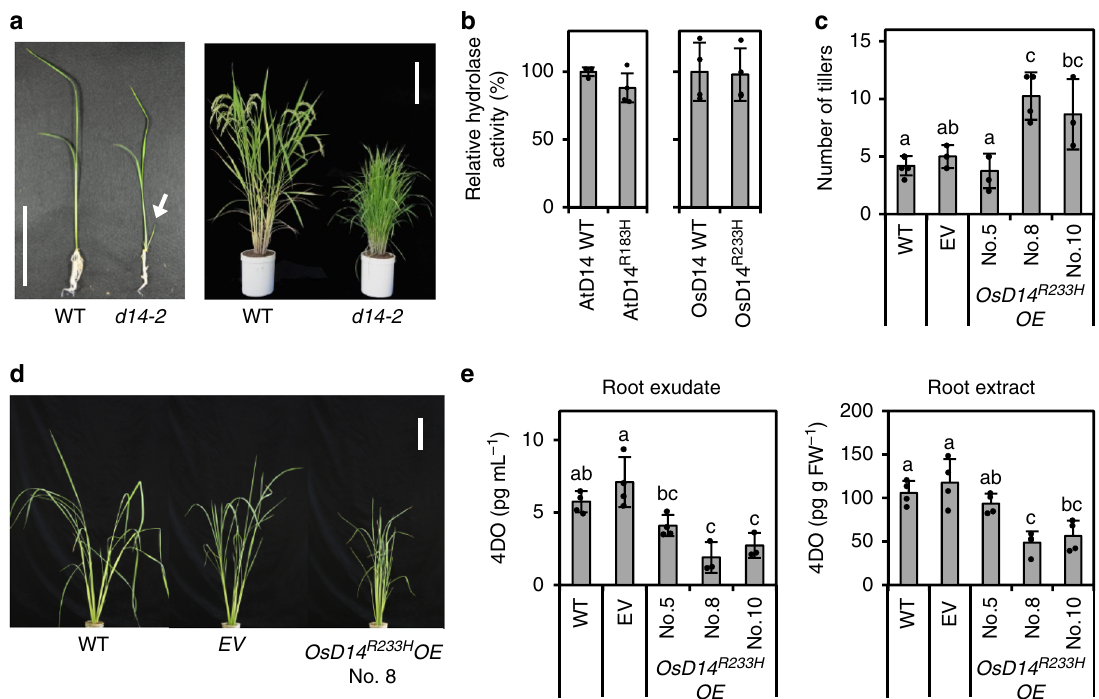
Fig. 4 In vitro and in vivo functional analysis of OsD14 R233H /AtD14 R133H . a Phenotypes of 2 weeks old seedlings (left) and mature plants (right) of the rice d14-2 mutant. The white arrow in the left picture indicates the outgrowing tiller. Scale bars = 5 cm (left panel), 20 cm (right panel). b Hydrolase activities of OsD14 R233H and AtD14 R133H mutants using 1 μ M 5DS as a substrate. Data are the means± SD ( n = 3 – 4). c No. of tillers of rice transgenic plants overexpressing OsD14 R233H in the WT (Nipponbare) background. Empty vector expressing plants are indicated as EV. Data are the means ± SD ( n = 3 – 5). d Phenotypes of 42 days old transgenic plants overexpressing OsD14 R233H ( OsD14 R233H OE ). Scale bars = 10 cm. e Quantitative analysis of 4DO in the root exudates (left panel) and extracts (right panel) of OsD14 R233H overexpressing ( OsD14 R233H OE ) plants. Data are the means ± SD ( n = 3 – 4). Different letters in c and e indicate signi fi cant differences at P < 0.05 with Tukey-kramer multiple comparison test. Source data are provided as a Source Data fi